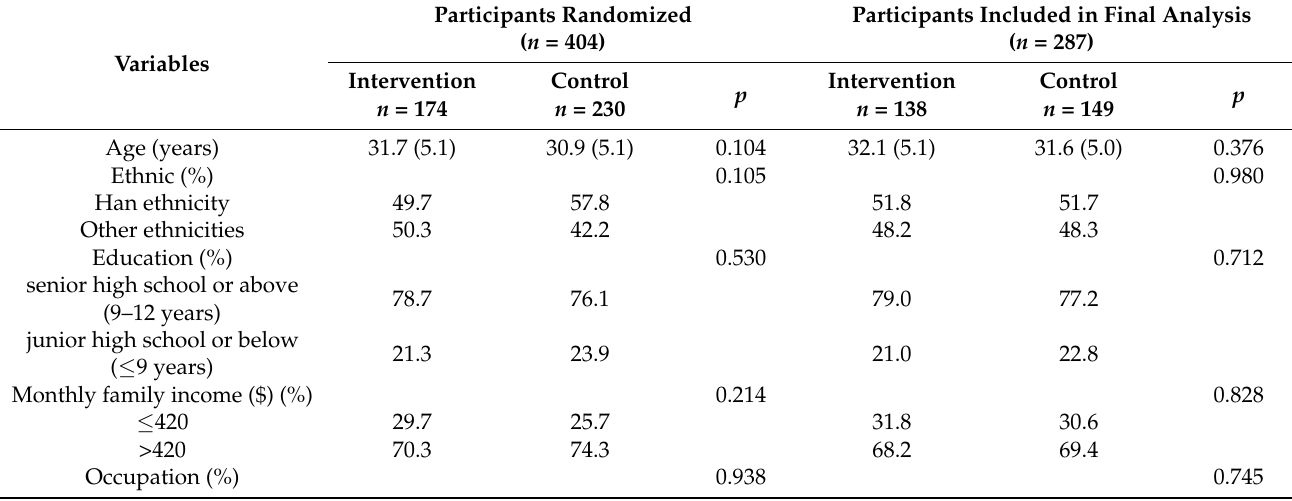
Table 1. Baseline characteristics of participants.